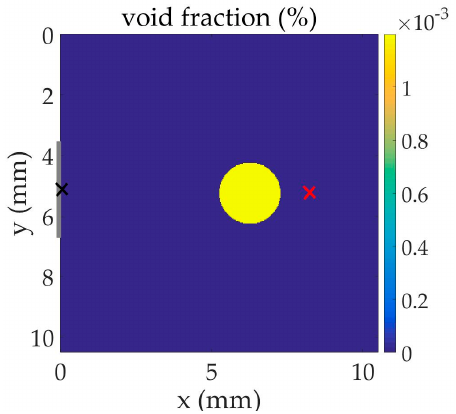
Figure 1. Schematic representation of the two-dimensional problem in which the black and red crosses represent the input and output signal positions, respectively.